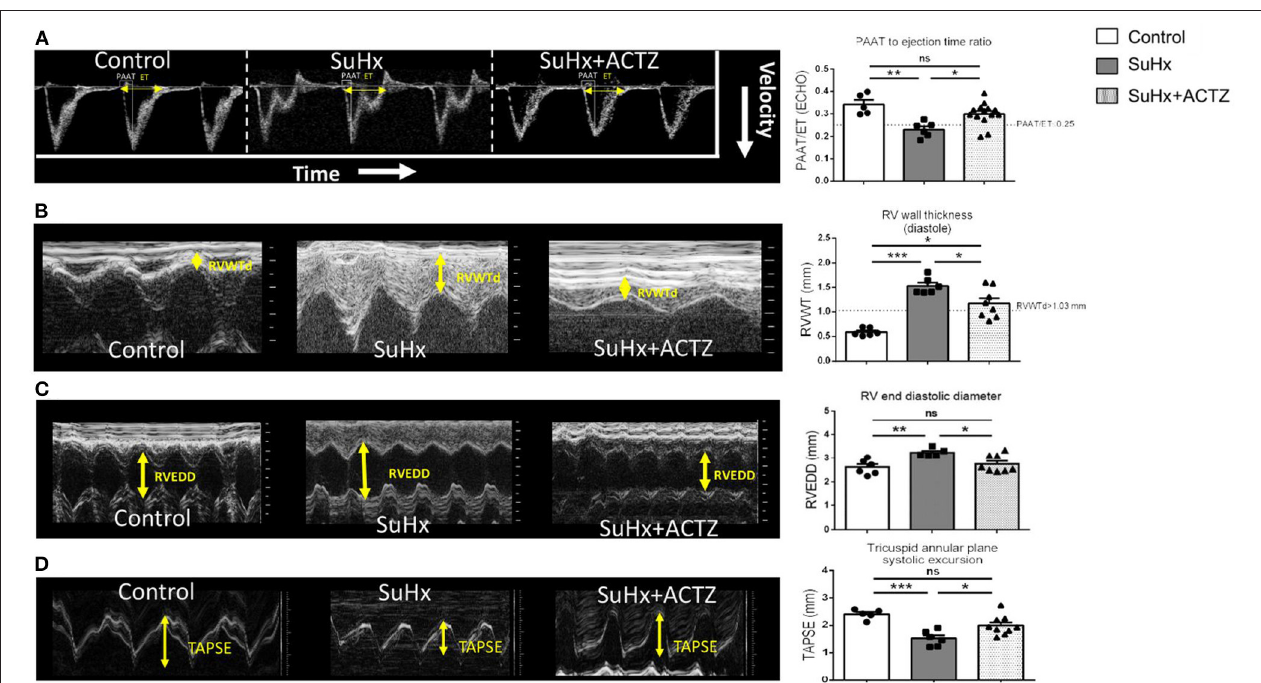
FIGURE 4 | Improved echocardiographic parameters in Sugen 5416/hypoxia (SuHx)-induced pulmonary hypertension (PH) with acetazolamide (ACTZ) treatment. (A) Pulmonary artery acceleration time to ejection time ratio (PAAT/ET). Representative pulmonary artery Doppler waveform and quantitative data ( n = 5–14 animals per group). (B) Right ventricular (RV) wall thickness in diastole (RVWT). Representative M-mode images from the right parasternal long axis imaging view and quantitative analysis ( n = 6–8 animals per group). (C) RV end-diastolic diameter (RVEED). Representative M-mode images and quantitative data ( n = 5–8 animals per group).